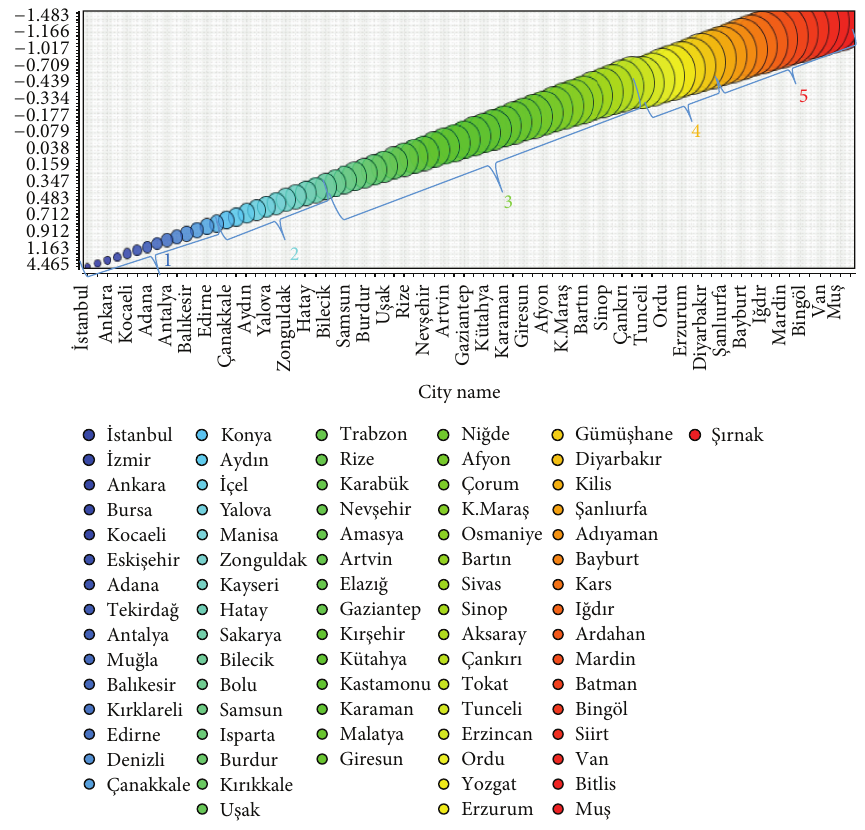
Figure 5: Clustering cities according to their welfare indexes